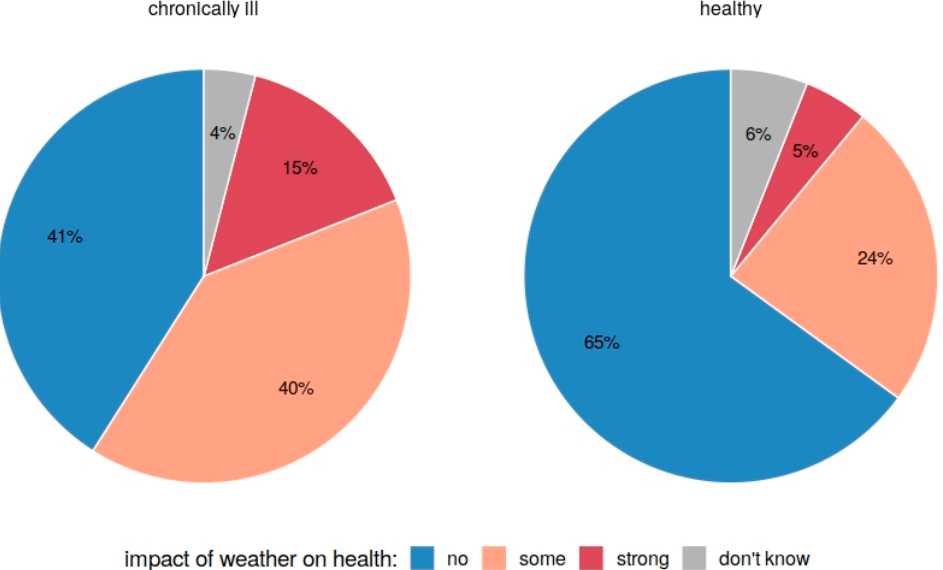
Figure 4. Chronically ill people are more often weather-sensitive than healthy people. The data are based on representative surveys conducted by IfD Allensbach in January 2021 (respondents’ self-assessment).